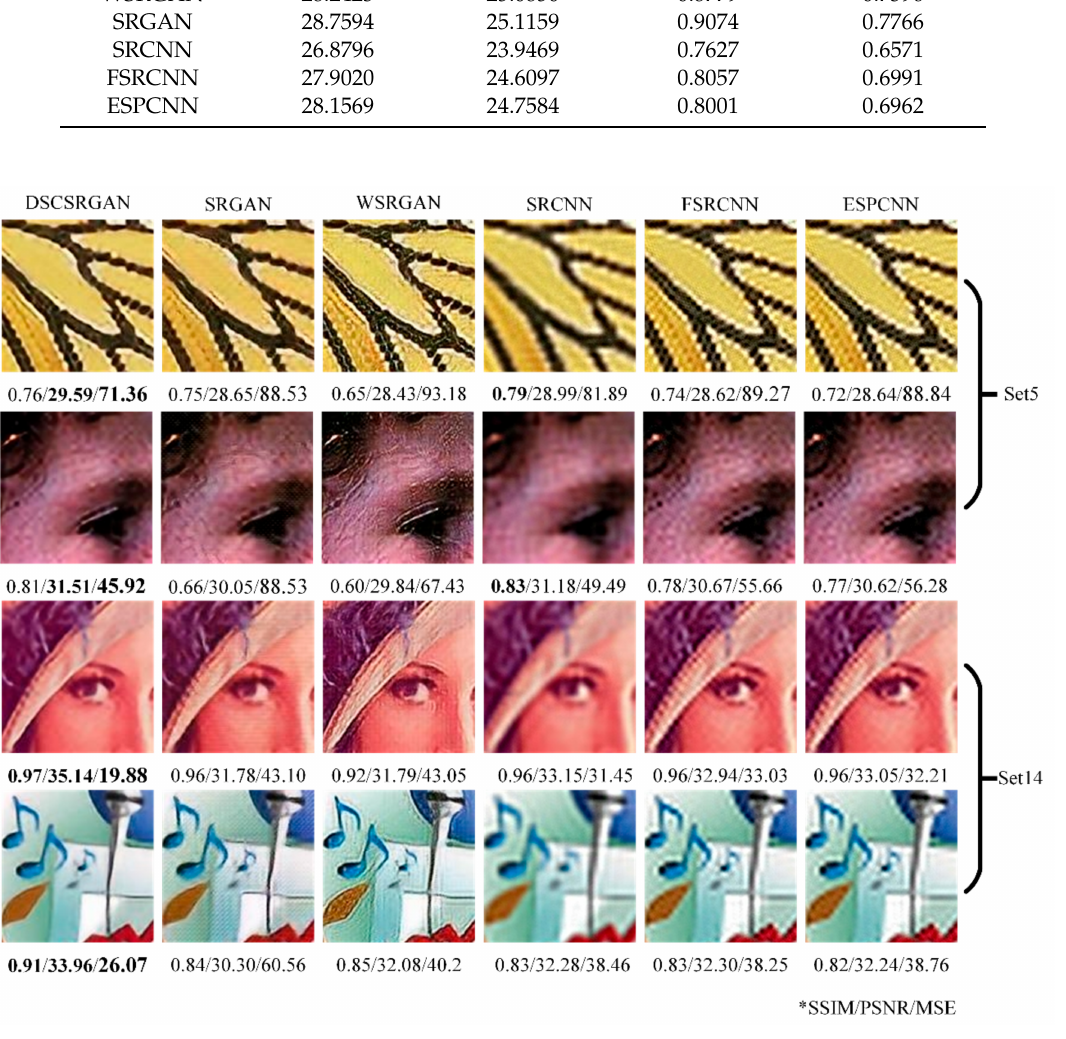
Figure 4. Super-resolution image reconstruction e ff ect comparison schematic diagram. From left to right: DSCSRGAN, SRGAN, WSRGAN, SRCNN, FSRCNN, ESPCNN. Corresponding PSNR, SSIM, and MSE are shown below the figure. (4 × upscaling) (Best viewed in